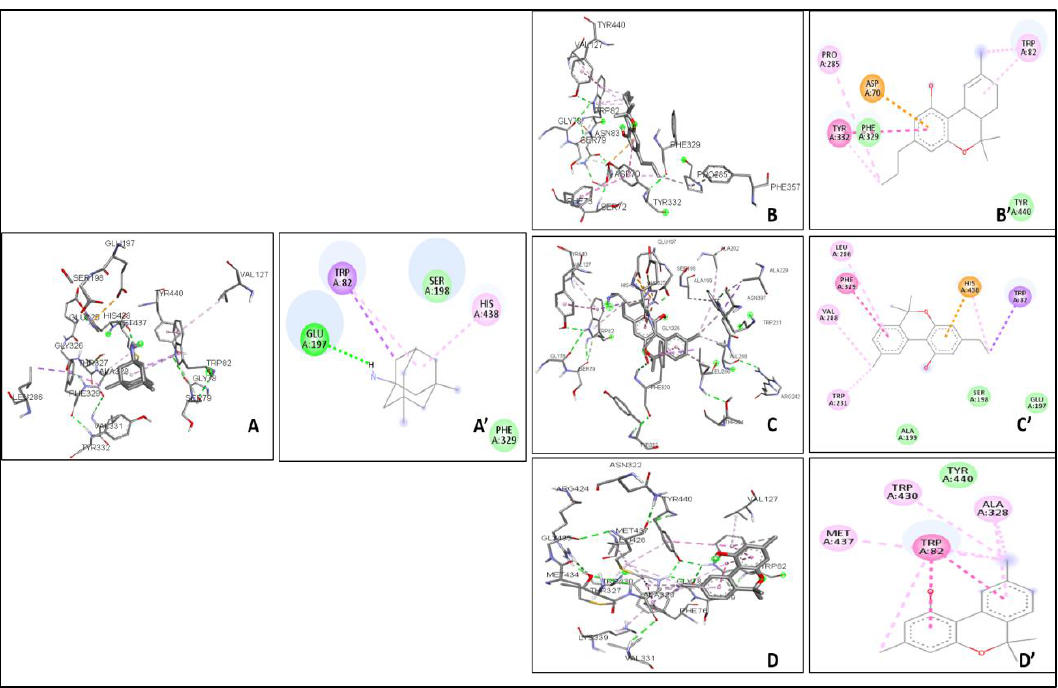
Figure 5. Interaction of Butyrylcholinesterase with drugs ( A , A’ ) and compounds ( B –D’ ) ( A ) 3D in- teraction with Memantine. ( A’ ) 2D interaction with Memantine. ( B ) 3D interaction with THCV. ( B’ ) 2D interaction with THCV. ( C ) 3D interaction with Cannabinol C2. ( C’ ) 2D interaction with Canna- binol C2. ( D ) 3D interaction with Cannabidiorcol. ( D’ ) 2D interaction with Cannabidiorcol.